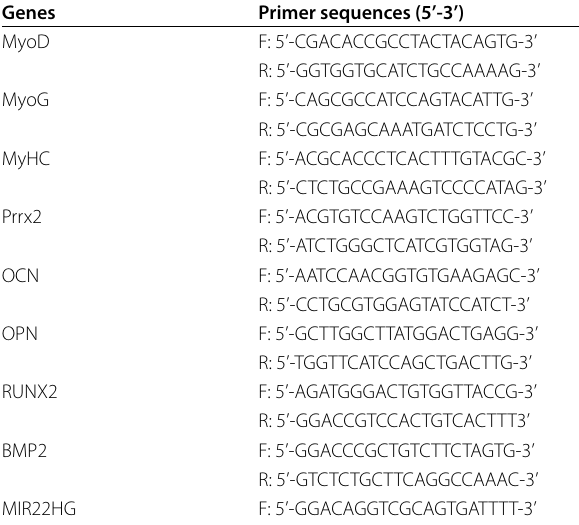
Supplementary Fig. 1 Prrx-2 is up-regulated during myogenic differentiation of C2C12 cells. (A) Morphol- ogy of C2C12 cells after myogenic differentiation for 1 d, 4 d, and 7 d. qRT-PCR analysis of MyoD (B), MyoG (C), MyHC (D) and Prrx-2 (E) mRNA expression. (F&G) Western blotting analysis of MyoD, MyoG, MyHC